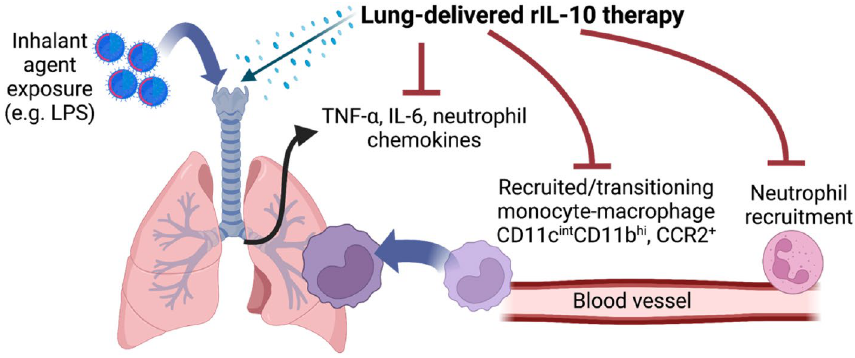
Figure 8. Schematic of lung-delivered rIL-10 treatment effects upon acute LPS-induced airway inflammatory consequences. Post-LPS exposure induced lung pro-inflammatory cytokine/chemokine release with corresponding recruitment of lung monocyte-macrophage subpopulation (CD11c int CD11b + ) and/or CCR2 + monocytes/macrophages and neutrophils is reduced with rIL-10 therapy (Created with BioRender.